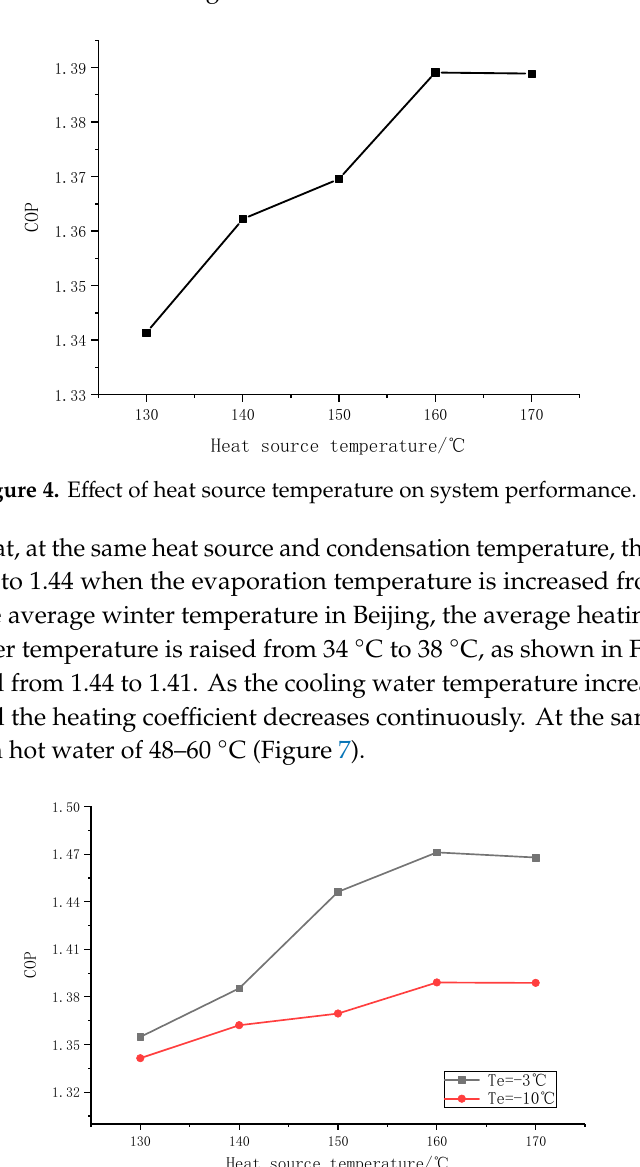
Figure 6. Effect of heat source and cooling water temperatures ( T c ) on system performance. Figure 7. Effect of heat source and cooling water temperatures ( T c ) on cooling water outlet temperature.